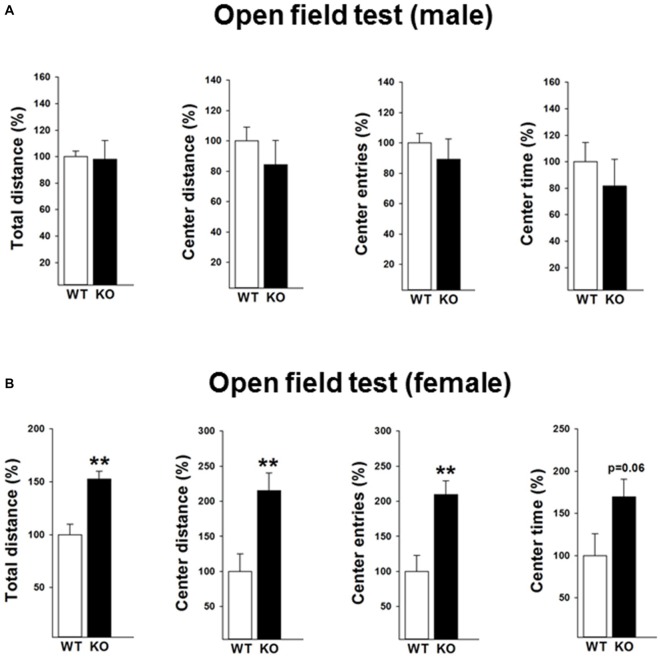
Reduced anxiety in the open field test in the female p75NTRexon IV−/− mice (B). They show significantly higher total distance and center distance traveled and more center entries. An increased center time (trend) was also observed. Results of male mice are depicted in (A). WT, white bar; KO, black bar. WT data are normalized to 100%. Group Mean + SEM; Male WT: total distance = 2177.8 + 92.4 cm, center distance = 353.4 + 31.8 cm, center entries = 30.3 + 1.9, center time = 114.1 + 16.6 s, Male p75KO: total distance = 2136.8 + 307.34 cm, center distance = 298.5 + 55.7 cm, center entries = 27.1 + 4.0, center time = 93.2 + 23.1 s, Female WT: total distance = 1760.2 + 171.9 cm, center distance = 143.6 + 36.1 cm, center entries = 14.6 + 3.3, center time = 50.1 + 12.9 s, Female p75KO: total distance = 2687.9 + 128.0 cm, center distance = 309.1 + 36.3 cm, center entries = 30.6 + 2.8, center time = 85.1 + 10.2 s Data are presented as Mean ± SEM, **p < 0.01.